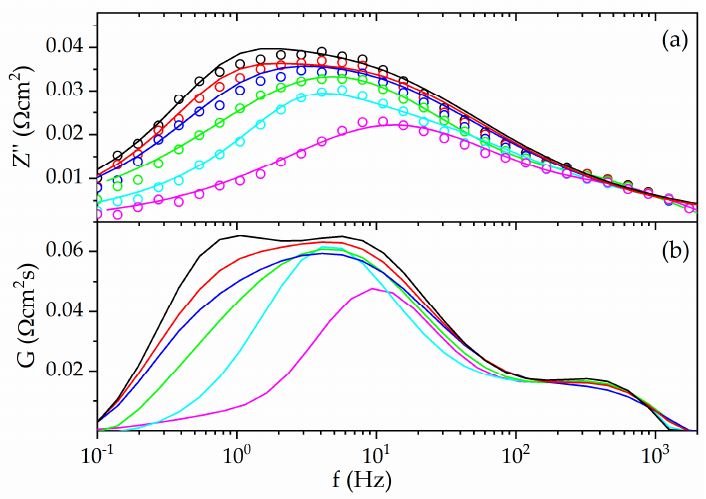
Figure 6. Imaginary part of impedance spectra ( a ) and distribution of relaxation times ( b ) at di ff erent aging time (T = 700 ◦ C): magenta = 0 h, cyan = 50 h, green = 100 h, blue = 150 h, red = 200 h, and black = 250 h. In ( a ) symbols represent experimental data and lines represent the best fit of data obtained by equivalent circuit described in the